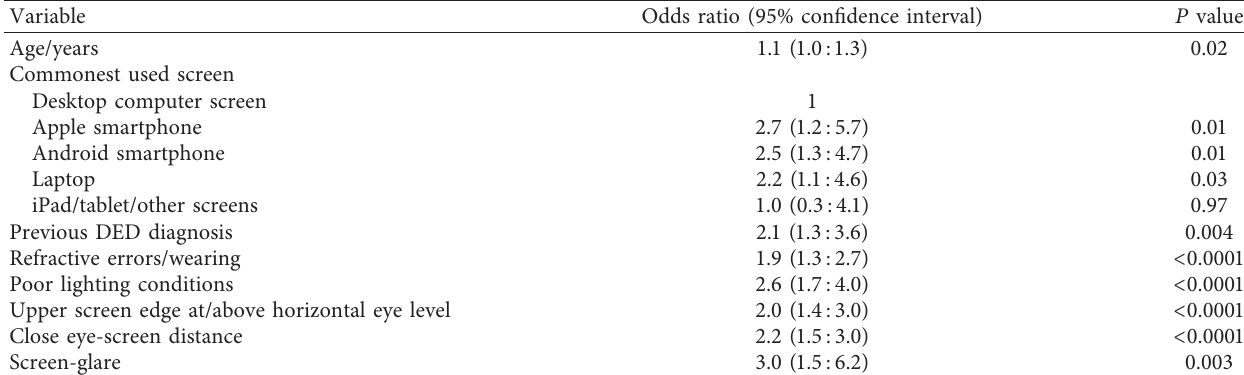
Table 6: Final multivariate logistic regression analysis of factors affecting the occurrence of blurred